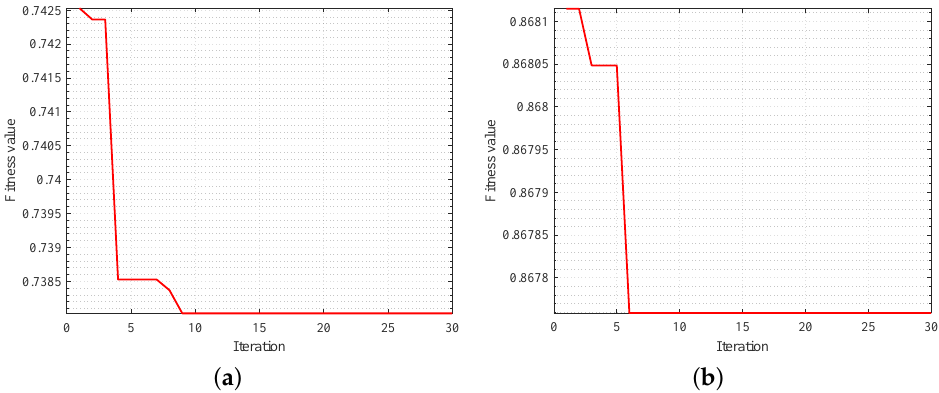
Figure 21. Convergence curve of fitness function of WOA-VMD-BD of measured data. ( a ) HH polarization mode. ( b ) HV polarization